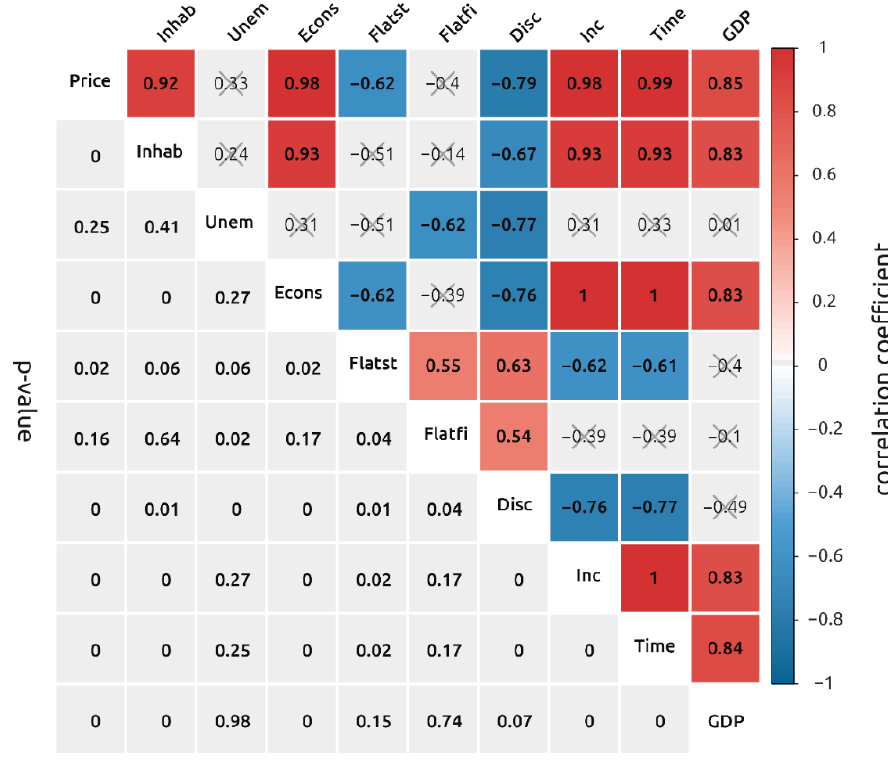
Figure 4. Correlation matrix for the city of Prague. Used abbreviations: Price - Land Price, Inhab - Inhabitants, Unem - Unemployment Rate, Econs - Registered Economic Subjects, Flatst - Started Flats, Flatfi - Finished Flats, Disc - Discount Rate, Inc - Household Income, Time - year, GDP - GDP